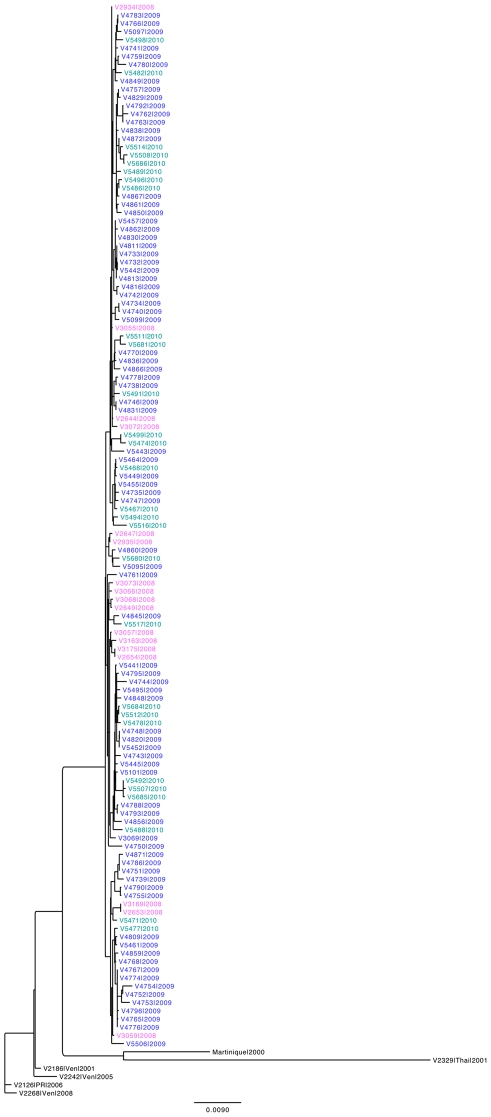
Phylogenetic analysis of Nicaraguan DENV-3 sequences from 2008–2010.Seventeen, 82, and 28 sequences from 2008 (pink), 2009 (blue) and 2010 (teal), respectively, were aligned using Muscle and clustered using phyML. Six isolates from Venezuela (“Ven”), Martinique (“Martinique”), Thailand (“Thai”) and Puerto Rico (“PR”) from the Asian-American genotype are also shown to root the tree and demonstrate similarities among the Nicaraguan isolates.